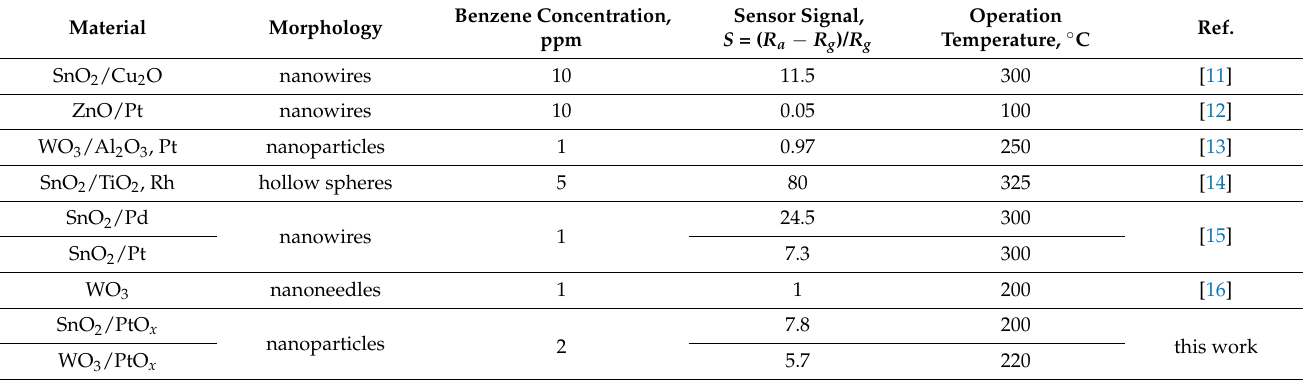
Figure 6. Dynamic response of WO 3 and WO 3 /PtO x sensors to increasing concentration of benzene at 220 ◦ C ( a ); dependence of sensor signals of WO 3 and WO 3 /PtO x sensors on C 6 H 6 concentration at 220 ◦ C ( b ); sensor signals of pristine and PtO x − modified MOS to 2 ppm C 6 H 6 in relation to temperature ( c ). Table 3. Composition of sensing behavior to benzene of the presently investigated resistive sensors and literature